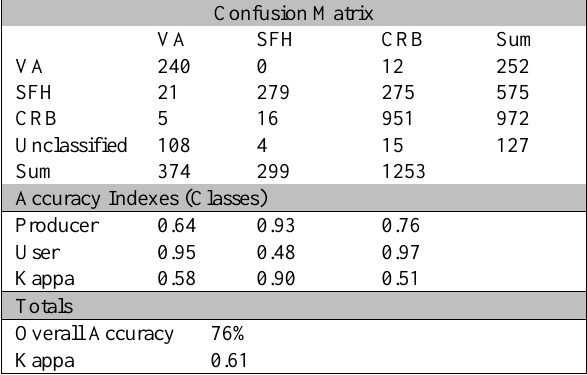
Table 2. Confusion matrix and class accuracy indexes of the UST classification. The name of the classes is shown